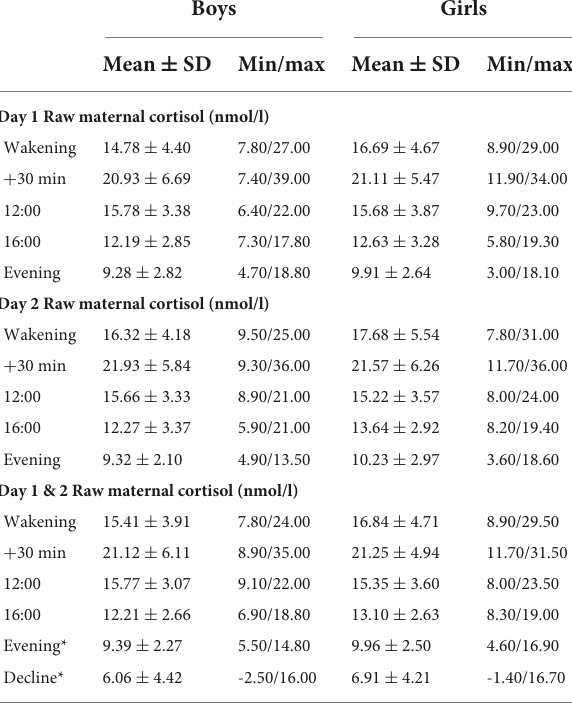
TABLE 2 Descriptive statistics of prenatal maternal cortisol